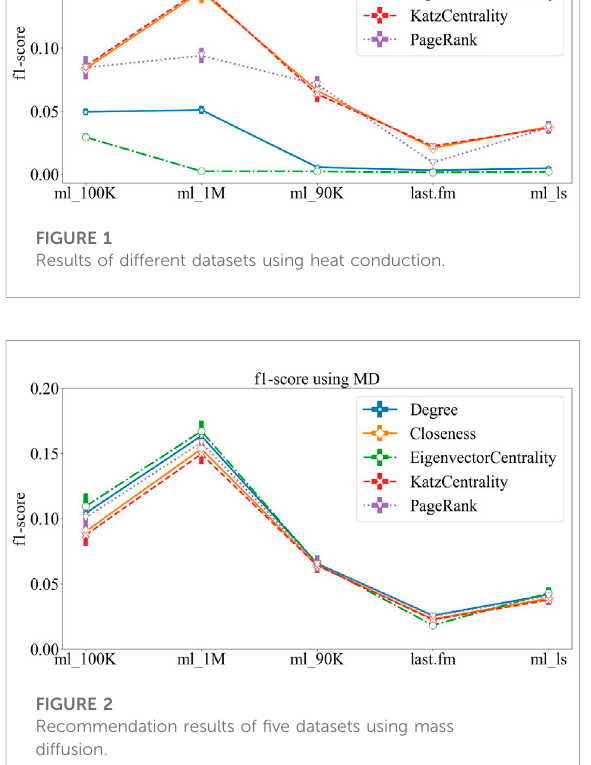
FIGURE 2 Recommendation results of fi ve datasets using mass diffusion.